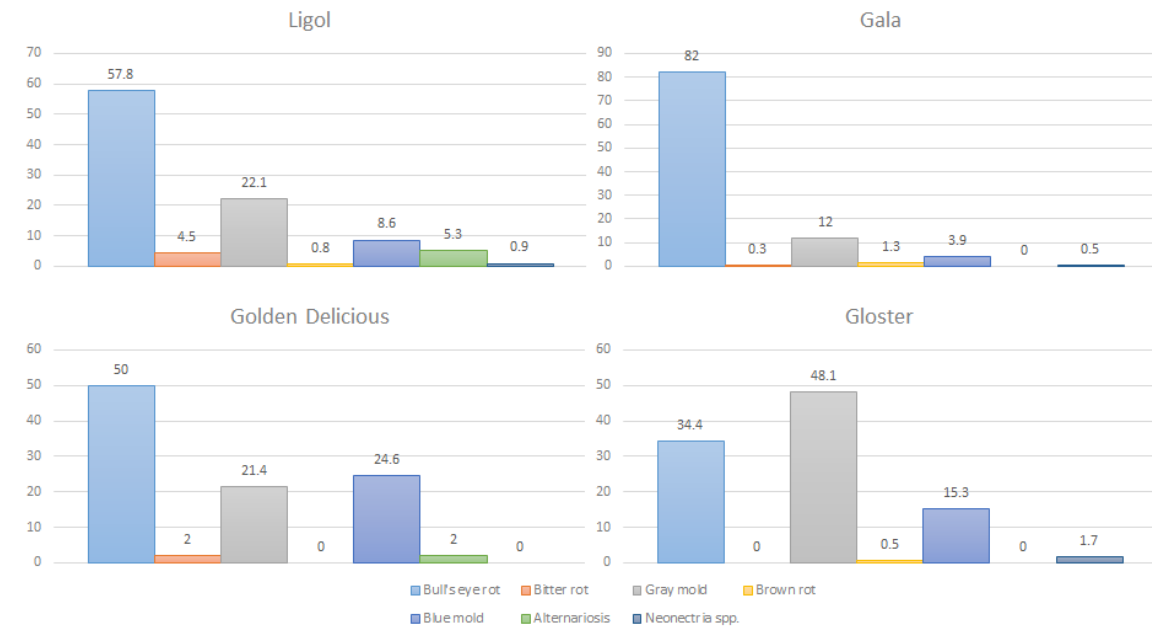
Figure 1. Share of diseases on cvs. “Ligol”, “Gala”, “Golden Delicious”, and “Gloster”.